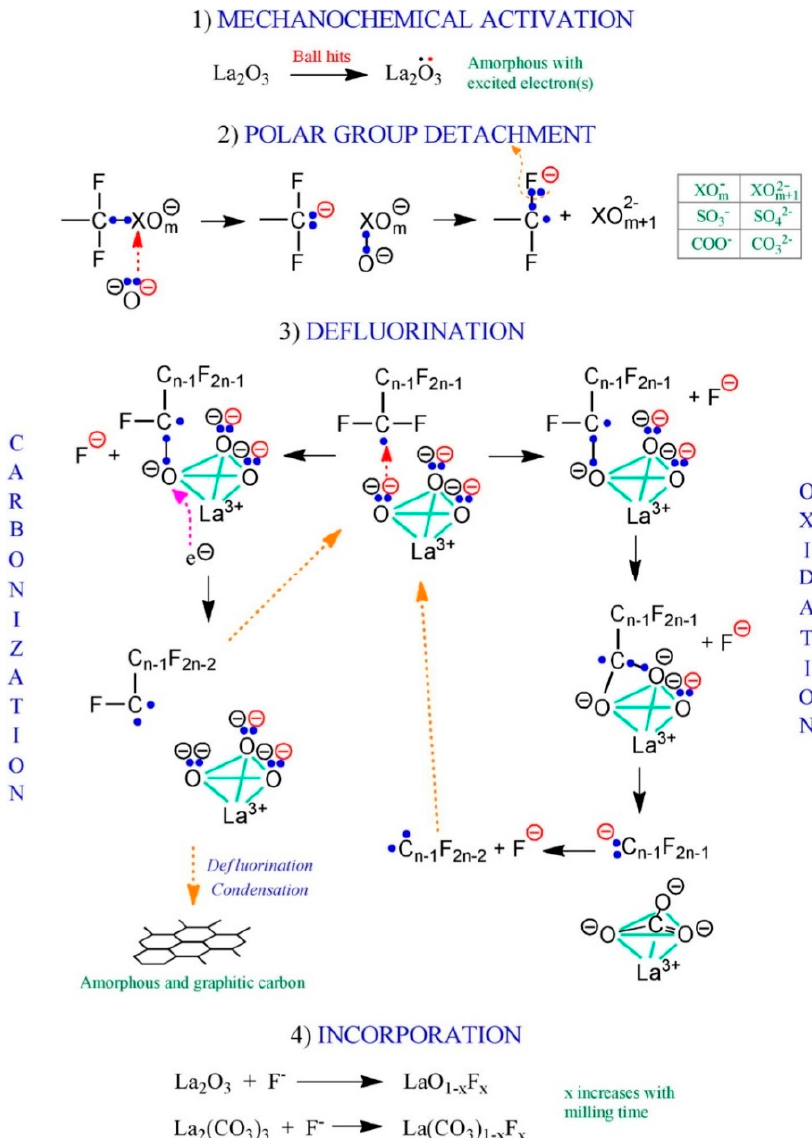
Figure 4. Proposed mechanistic pathways for the stoichiometrical activation of selected PFASs with La 2 O 3 (reprint from [119], with permission from